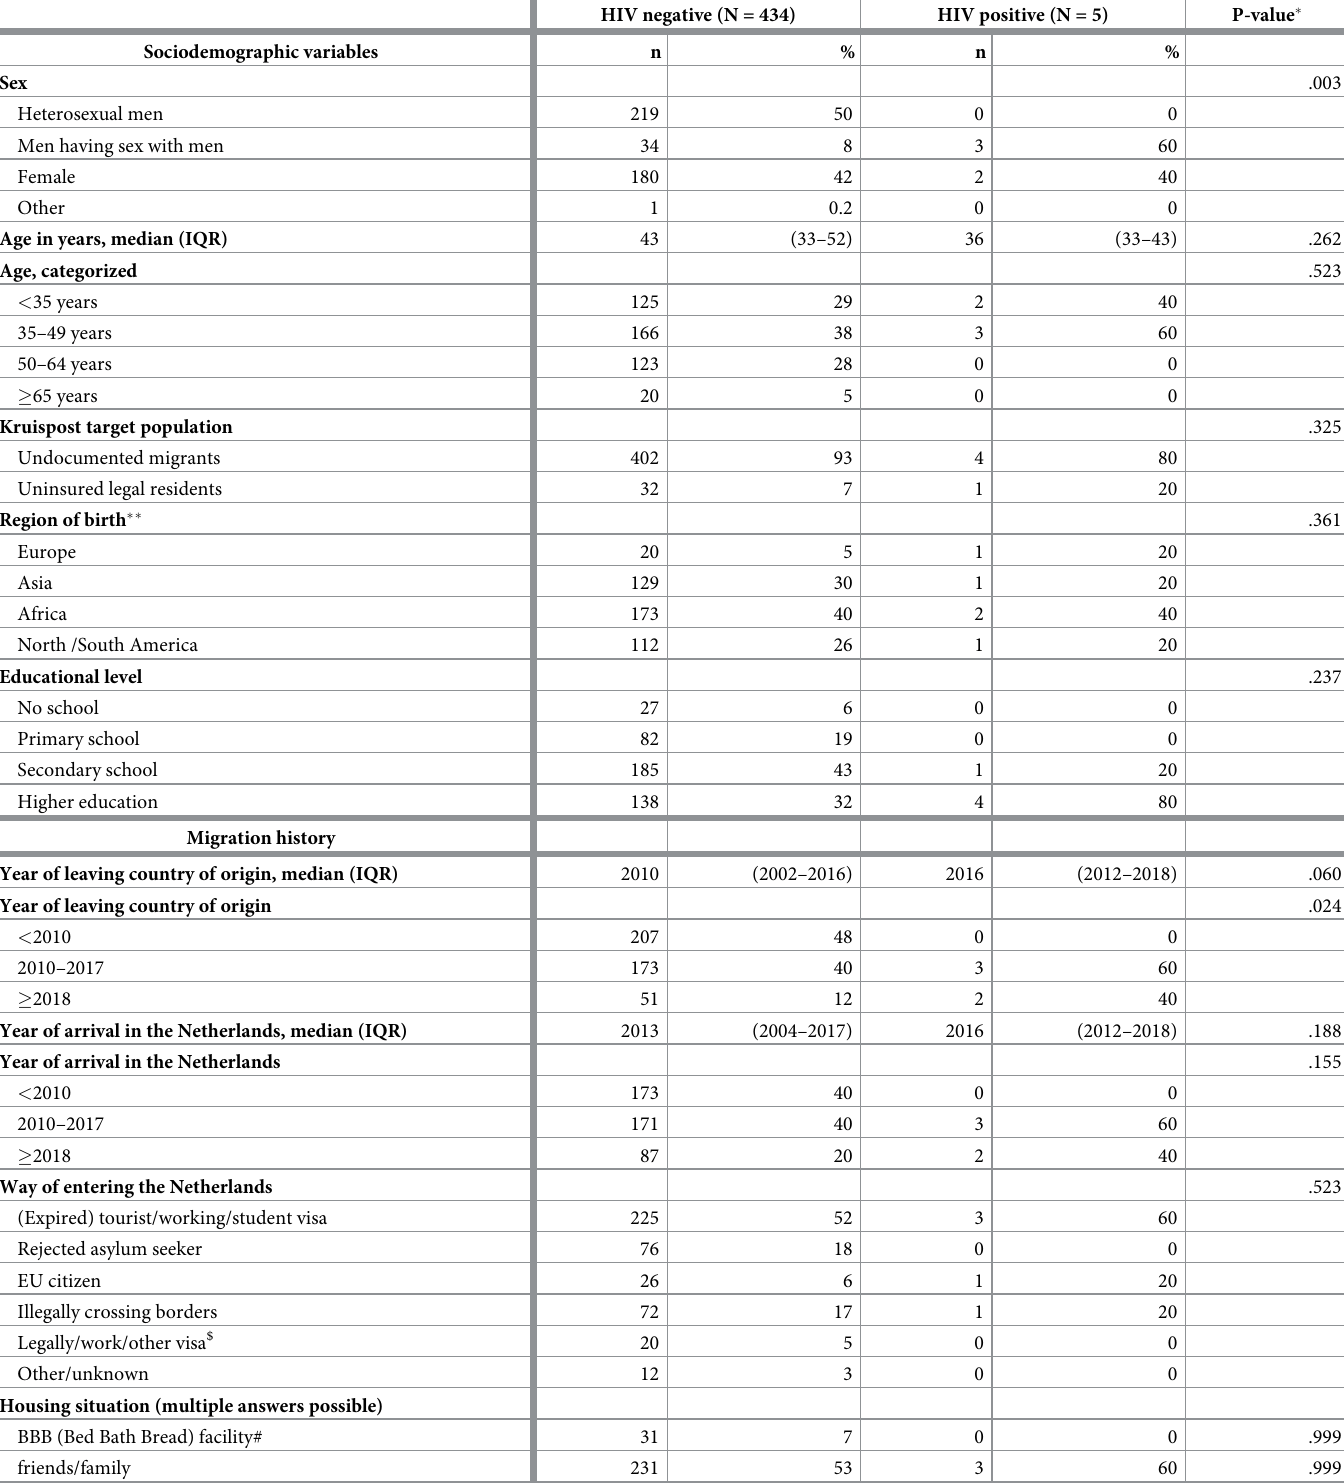
Table 6. Characteristics of undocumented migrants and uninsured legal residents tested for HIV (N = 439) by HIV status, in Amsterdam, the Netherlands, October 2018- October